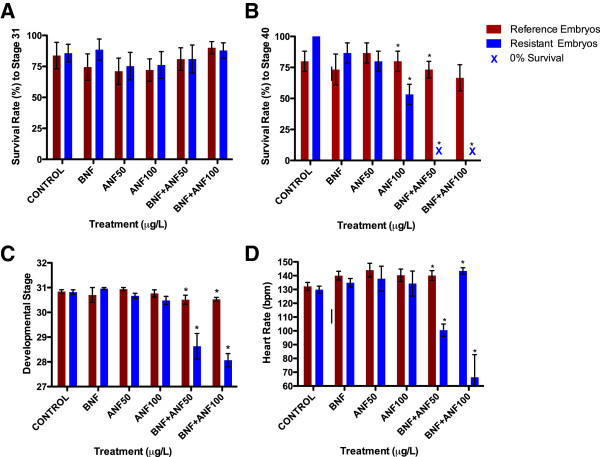
Survival, developmental delays, and heart rates of reference (Kings’ Creek – blue) and resistant (Elizabeth River – red) Fundulus embryos. A) Embryo survival (2-way ANOVA, p = 0.97) among five treatment groups within reference and resistant embryo populations at developmental stage 31 (late organogenesis). Sensitive and resistant embryo’s survival is not affected by any treatment at the stage 31.B) Hatching success and survival to stage 40 (2-way ANOVA, p < 0.01) among reference and resistant embryos. The cumulative effects in both combined treatments have significant effect among sensitive embryos, as they fail to hatch, while the resistant embryo survival is largely unaffected. C) Development among control and five treatment groups of reference and resistant embryos at 144–150 hours post-fertilization: although most of the embryos reached stage 31 within the expected time period, significant developmental delays were noted among reference embryos exposed to both low and high ANF + BNF treatments (2-way ANOVA, P <0.01). Reference embryos were significantly delayed (on average 3 developmental stages, ~ 40 h) relative to resistant embryos in both combined treatments (Bonferroni post-test analysis, p < 0.01), while embryo development in discrete treatments did not significantly differ. D) Embryo heart rates: reference and resistant embryos’ heart rates during stage 31: significant bradycardia (2-way ANOVA, p < 0.01) were noted among reference embryos at both lower (p < 0.04; t = 4.12) and higher (p < 0.05; t = 8.03) BNF/ANF dose exposures relative to resistant embryos. Asterisks (*) represent statistically significant within-treatment differences (Student’s t-test, p < 0.05) between Elizabeth River (resistant) and King’s Creek (reference) embryos.